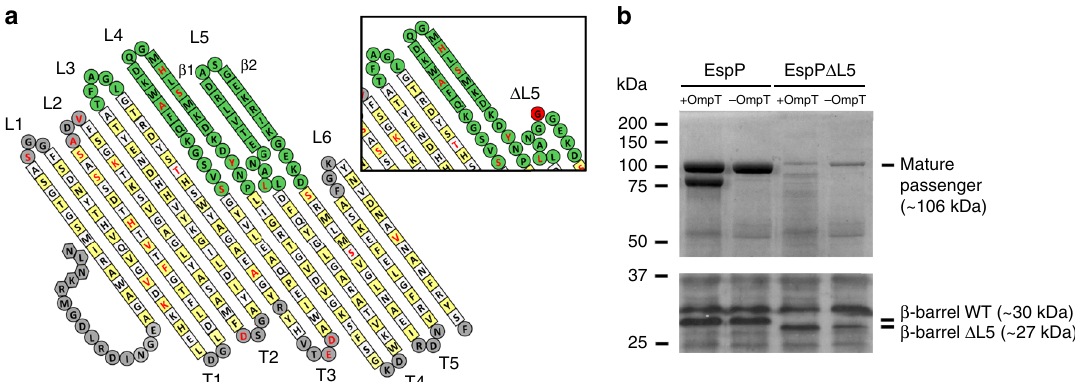
Fig. 3 Truncation of L5 affects folding of the EspP passenger domain. a Left panel: Topology model of the EspP β -barrel domain based on its crystal structure (PDB code 3SLJ). Yellow and white squares indicate residues with side chains that point toward the lipid bilayer and the β -barrel lumen, respectively. Residues in periplasmic turns labeled T1-T5 and extracellular loops labeled L1, L2, and L6 are shown in gray, as are the residues in the α -helical segment. Residues in extracellular loops labeled L3, L4, and L5 are shown in green and residues that differ in Pet are highlighted in red font. Right panel: topology model of the EspP β -barrel domain showing the L5 truncation created by replacing E 1238 – K 1251 with one glycine residue (shown in red). b SDS- PAGE of TCA-precipitated culture supernatant fractions (top panel) and immunoblotting of whole-cell lysates with anti-Pet β -barrel domain antibodies* (bottom panel) collected after growth of E. coli TOP10 ( + OmpT) and BW25113 Δ ompT ( − OmpT) expressing EspP and EspP Δ L5. Image is representative of at least two independent experiments. *The Pet and EspP β -barrel domains are so similar that anti-Pet β -barrel domain antibodies cross-react with